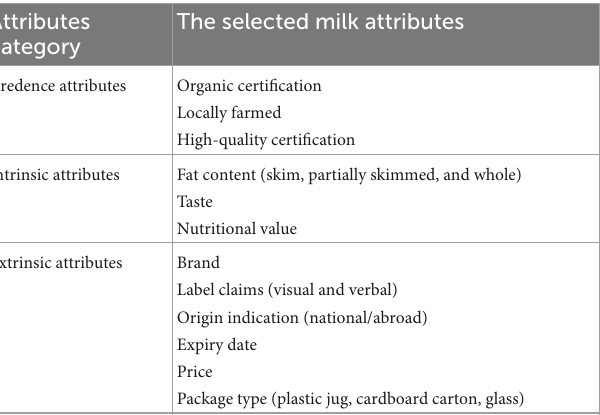
TABLE 2 Attributes analyzed with the Best-Worst scaling